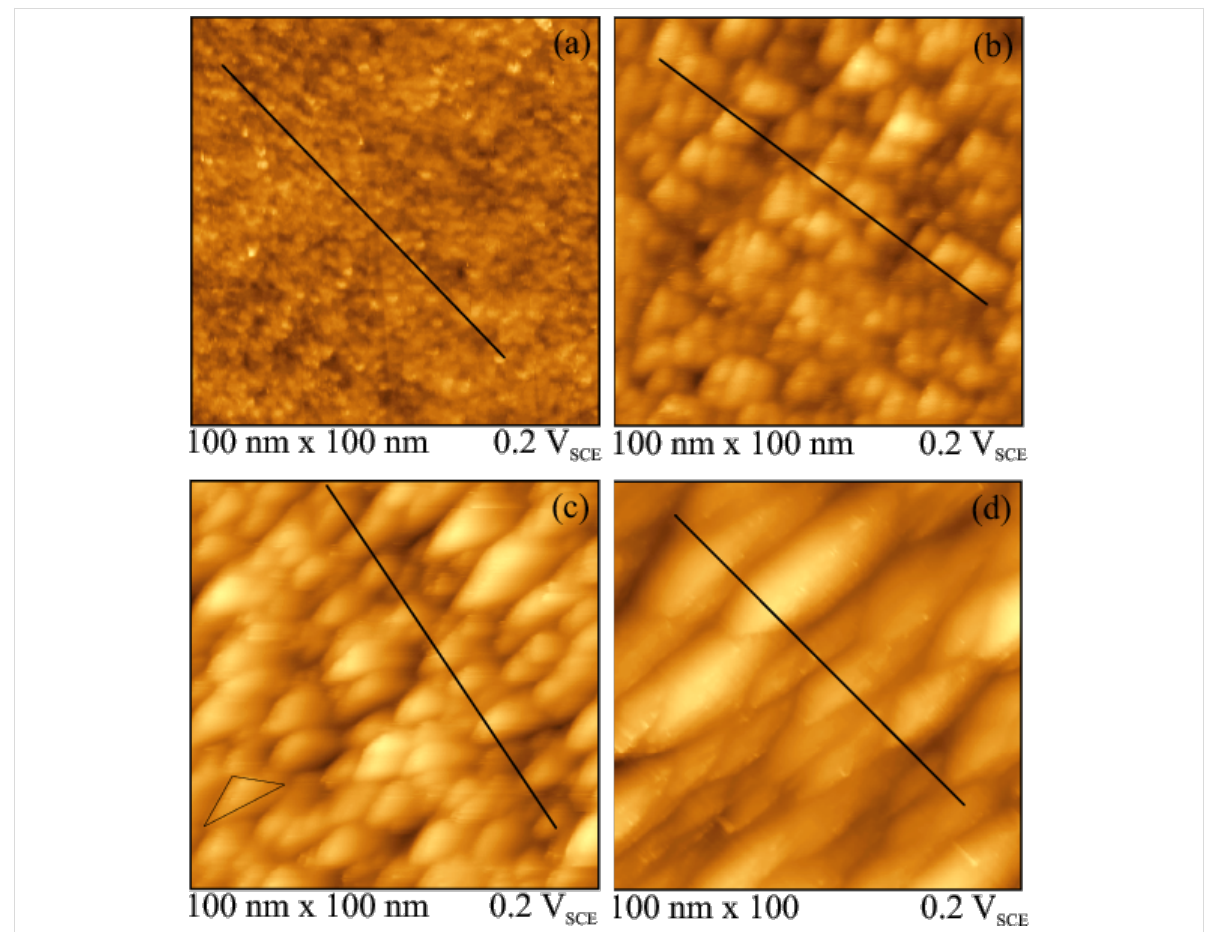
Figure 6: In situ STM images (100 × 100 nm 2 ) of CO-cooled Ir(210) surface in 0.1 M H 2 SO 4 after cycling between − 0.28 and 0.7 V at 1 V·s − 1 for (a) 1, (b) 20, (c) 60 and (d) 240